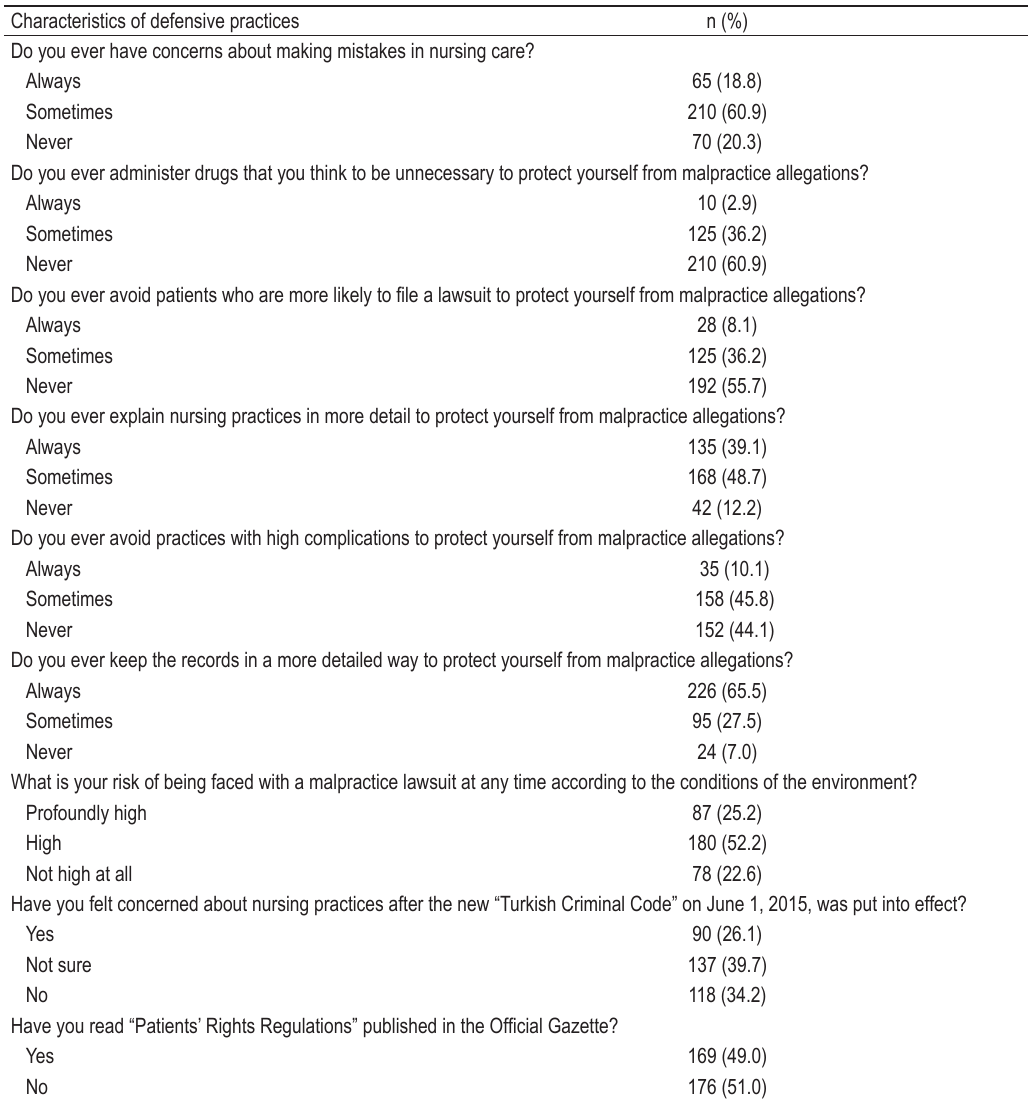
TABLE 2. Characteristics of nurses’ defensive practices (n=345) Characteristics of defensive